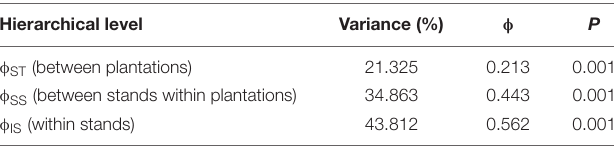
TABLE 3 | Analysis of molecular variance (AMOVA) table showing the partitioning of total genetic variability in the Leptographium wageneri var. pseudotsugae population among levels of a population